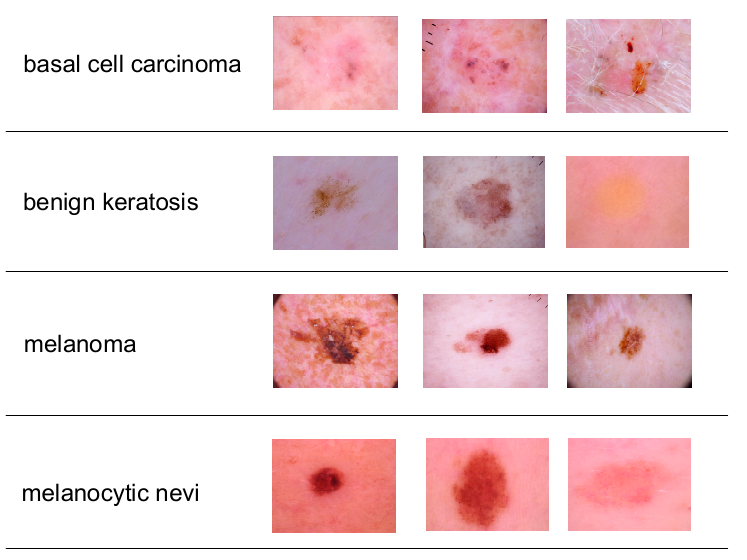
Figure 1. Sample images from the skin disease dataset.